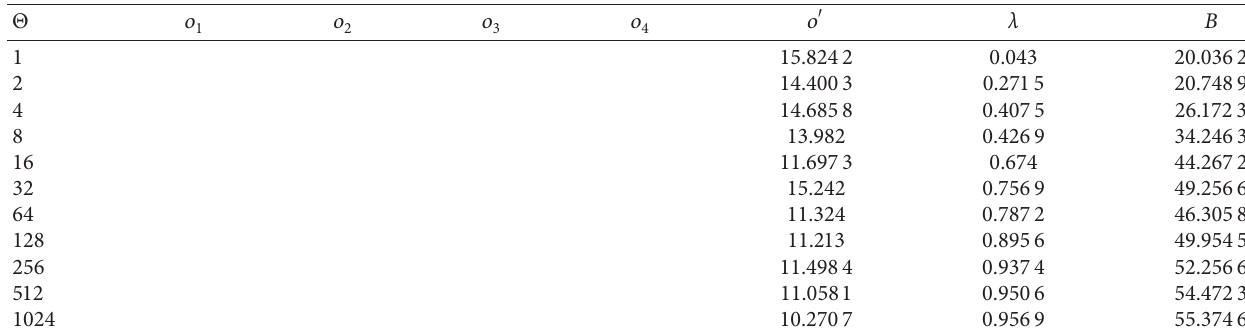
Table 6: Result of model (14).